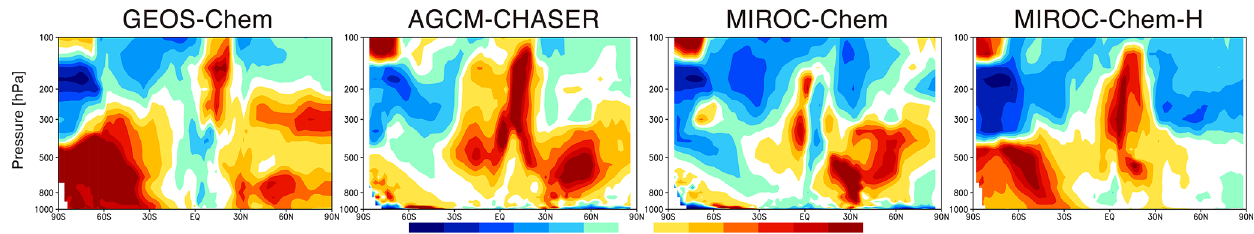
Figure 8. Latitude–pressure cross section of changes in seasonal amplitude of zonal mean ozone concentrations (ppbv) due to data as- similation (data assimilation minus control runs), as estimated from the maximum minus minimum values of the monthly mean ozone